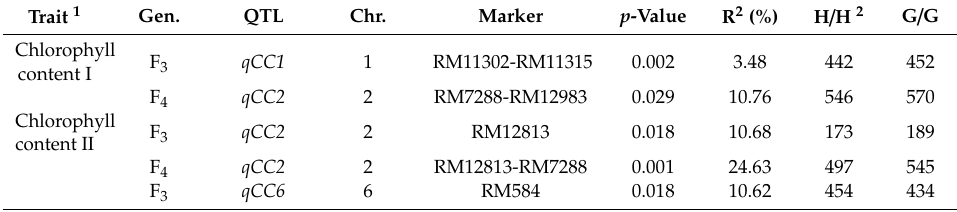
Table 2. QTLs (quantitative trait loci) for chlorophyll content based on one-way ANOVA in the F 3 and F 4 . Trait 1